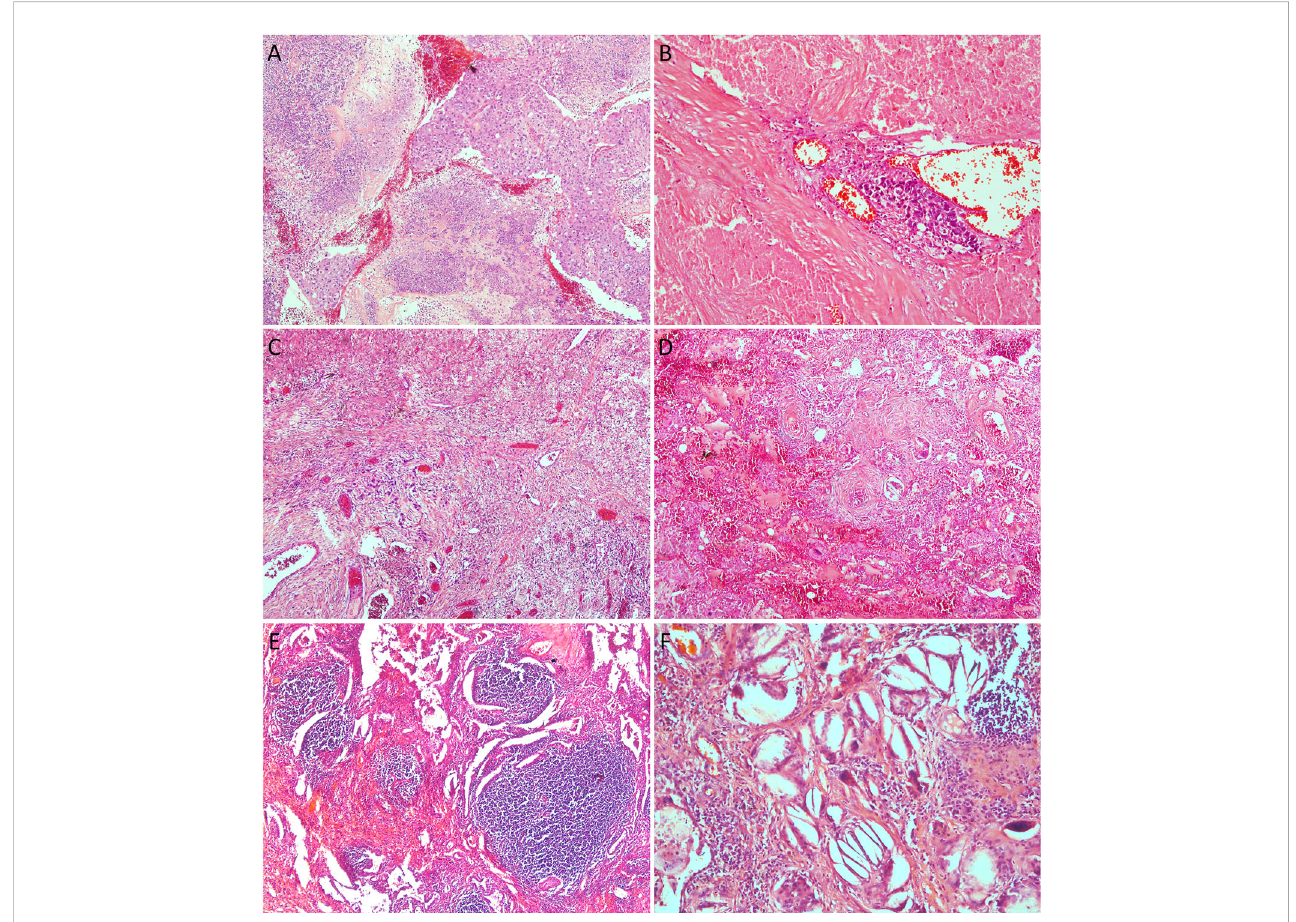
FIGURE 3 Histologic features after neoadjuvant therapy: (A) , area of solid nests of chemotherapy treated squamous cell carcinoma surrounded by necrotic areas (magni fi cation x 10); (B) , chemo-immunotherapy treated tumor with a large area of necrosis showing a single focus of viable adenocarcinoma (magni fi cation x 20); (C) , focus of atypical cells of chemo-immunotherapy treated tumor with adenocarcinoma histology surrounded by dense fi brosis (magni fi cation x 4); (D) , chemotherapy treated tumor with larger area of dense fi brosis with abundant foamy histiocytes (magni fi cation x 4); (E) , this area of chemo-immunotherapy treated tumor shows fi brosis with extensive in fl ammatory in fi ltrate of lymphocytes and plasma cells (magni fi cation x 4); (F) , high power of the same tumor showing chronic in fl ammation, cholesterol clefts, foamy histiocytes, and fi brosis.